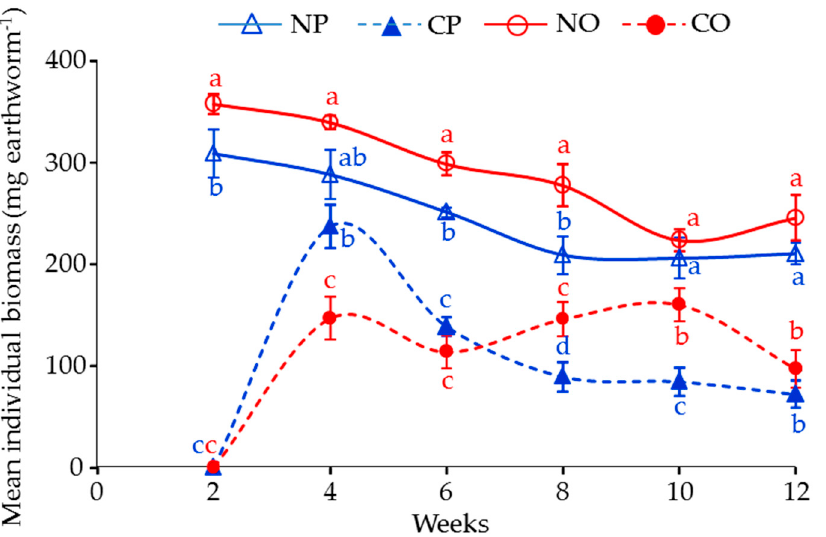
Figure 2. Evolution of the individual earthworm weight in the non-contaminated (NP and NO) and contaminated (CP and CO) biomixtures at each vermicomposting time. Error bars represent the standard deviation (n = 3). Different letters indicate significant differences between biomixtures ( p < 0.05) at each vermicomposting time.